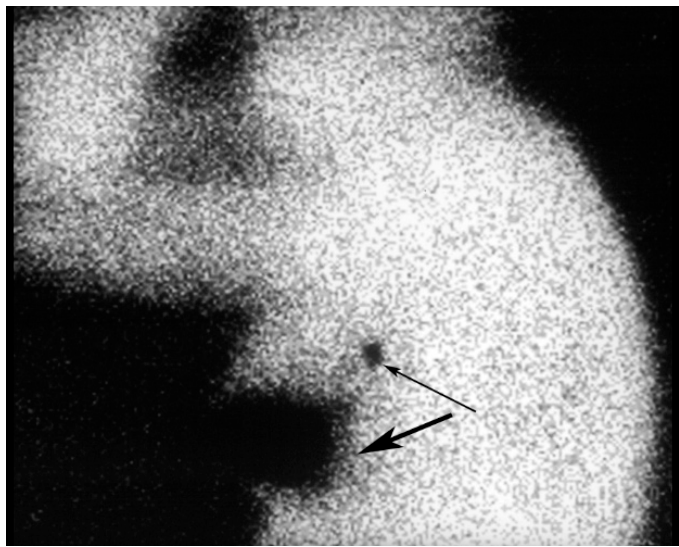
Figure 14. The lateral image shows the SLN (thin arrow). Marked uptake is noted in the tumor bed at the injection site (thick arrow).